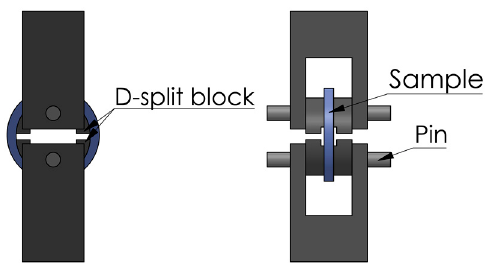
Figure 2. Setup of the D-split tensile test.